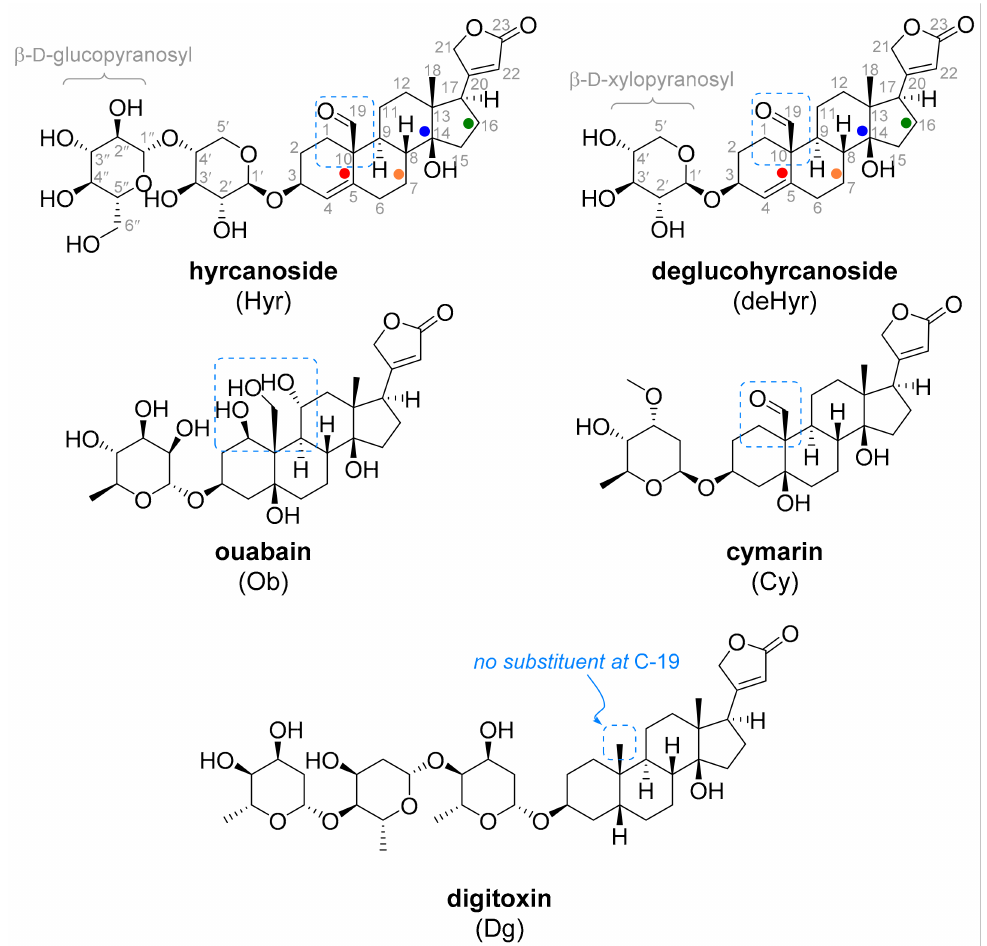
Figure 1. Structures of natural C-19-oxo cardiotonics and digitoxin. Carbon numbering of Hyr and deHyr is in grey. The ring designation of the steroid ring is highlighted by dots (i.e., the A ring is marked by a dot, B with , C with , and D with dot).